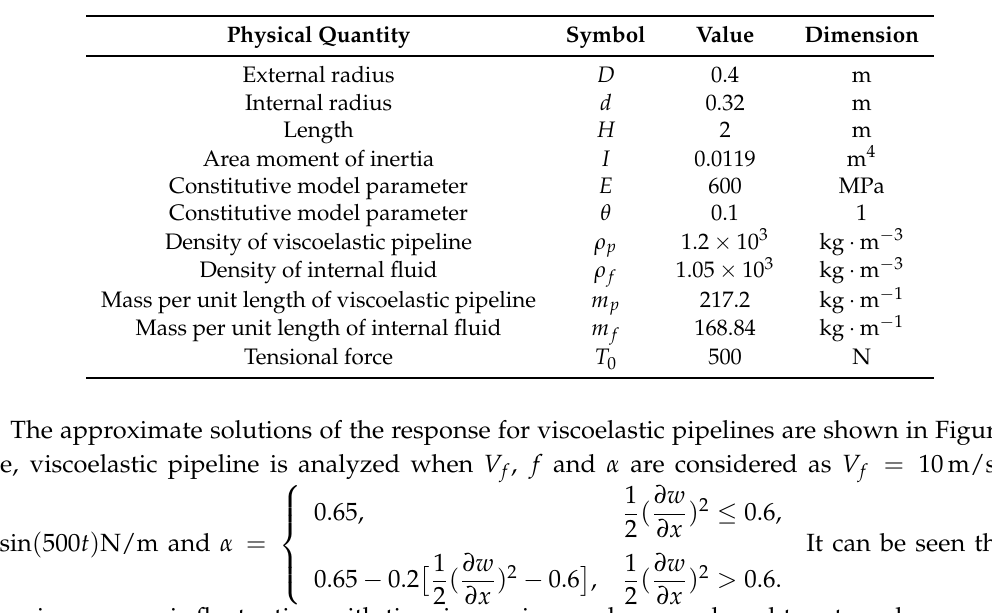
Table 1. The fixed parameters of viscoelastic pipeline and internal fluid.